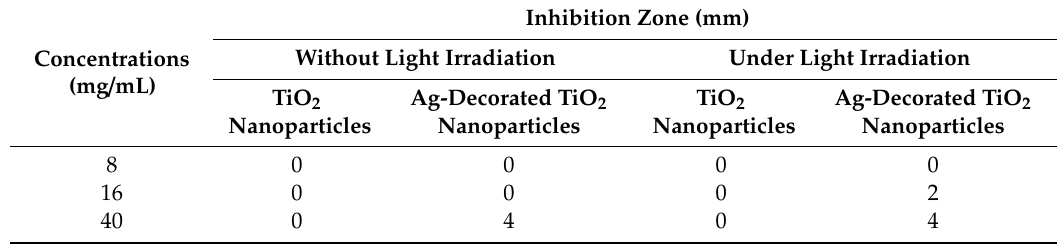
Table 1. Antibacterial activity against S. aureus bacteria of TiO 2 nanoparticles and Ag-loaded TiO 2 nanoparticles.